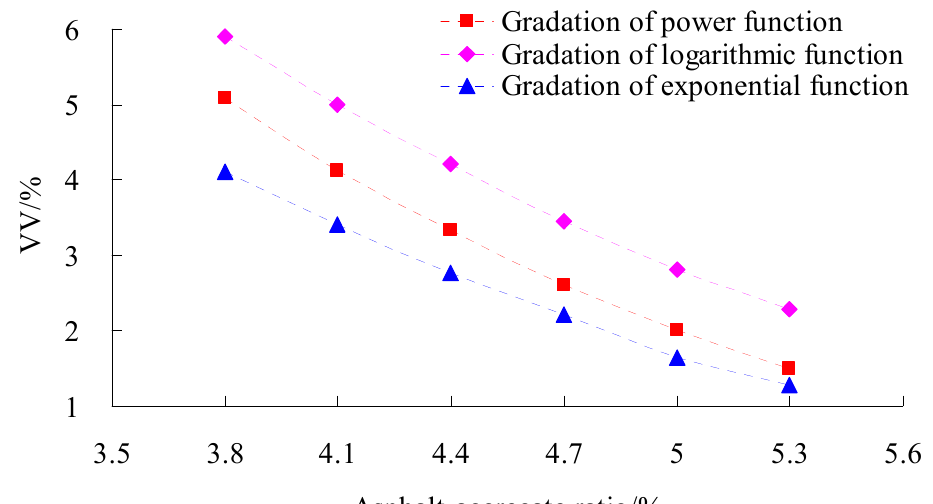
Figure 3. Tests results of VV.